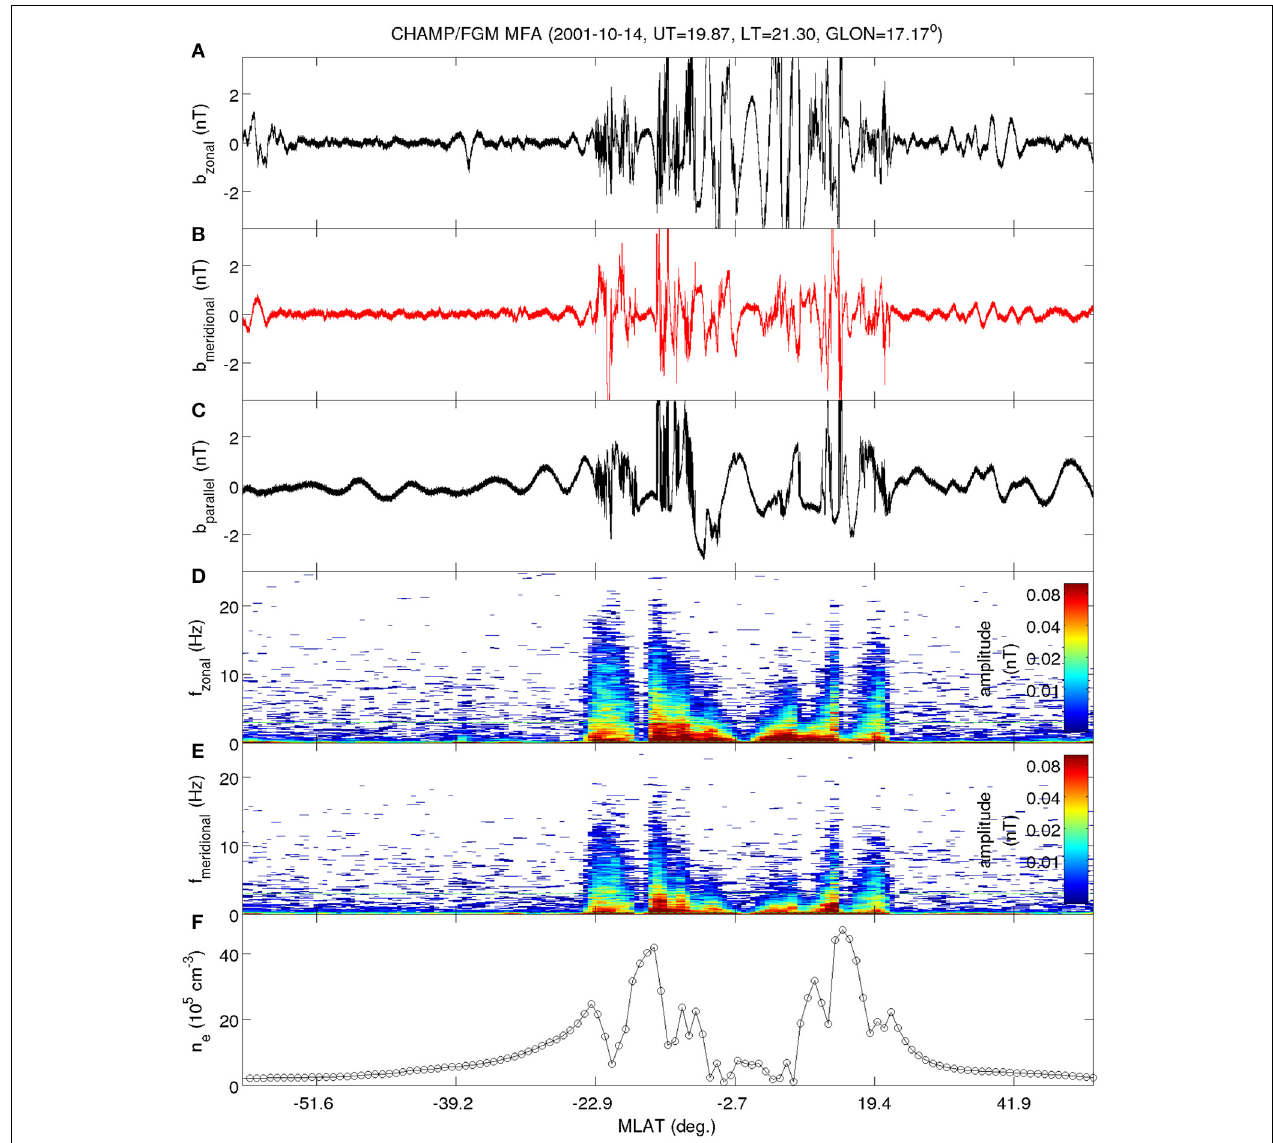
FIGURE 1 | Example of Alfvénic wave signatures associated with equatorial plasma bubbles. The (A–C) show the observed magnetic variations of the zonal, meridional and parallel components,